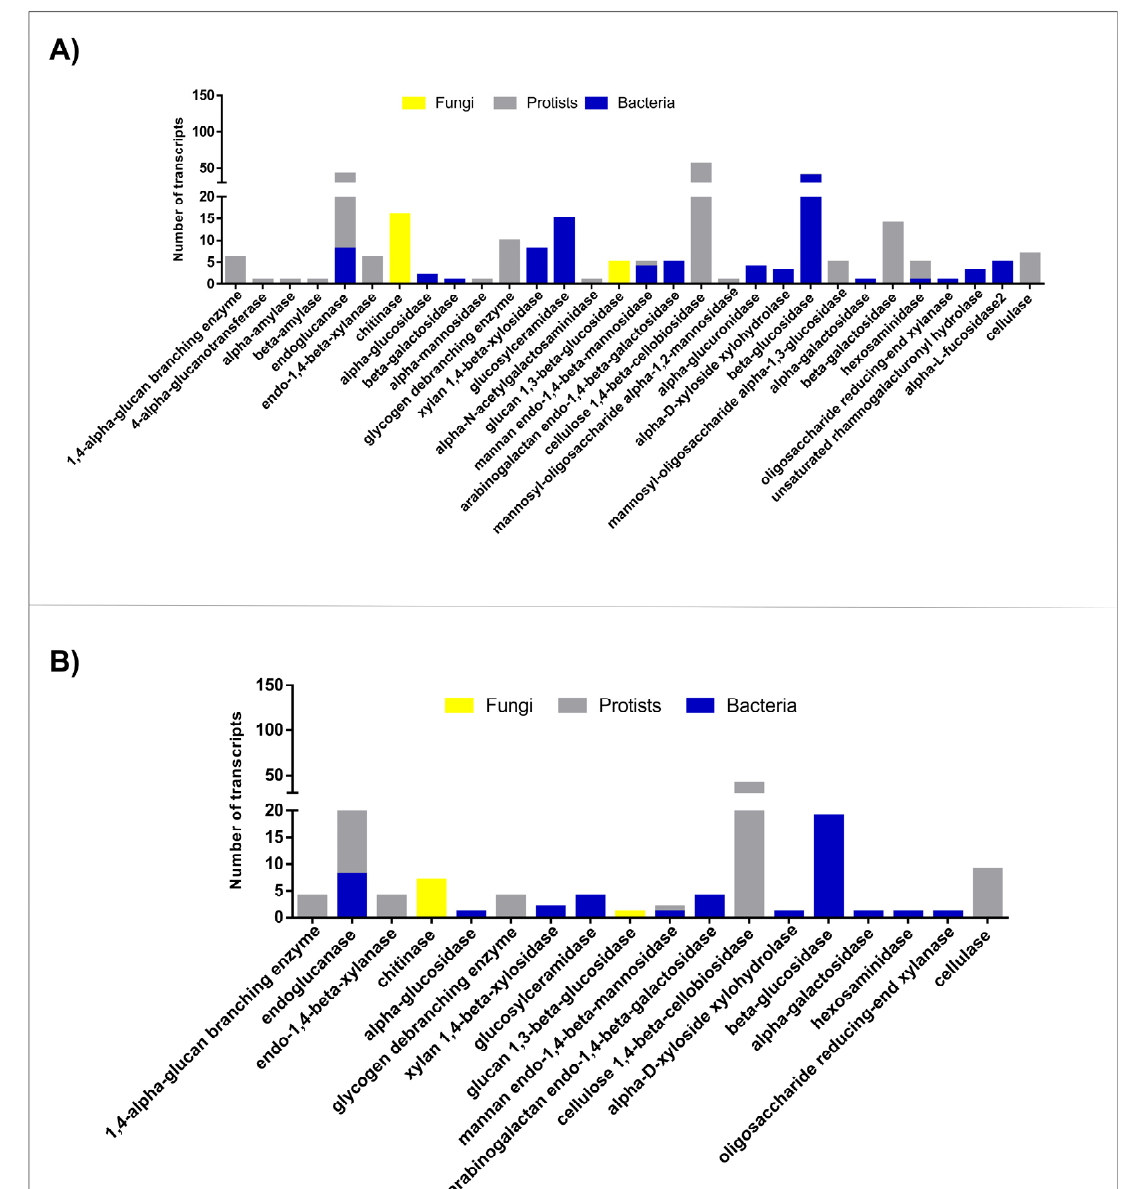
Figure 2. Glycoside hydrolases enzymes from the microbiota of H. tenuis , found in meta-transcriptomes of ( A ) workers and ( B ) soldiers.